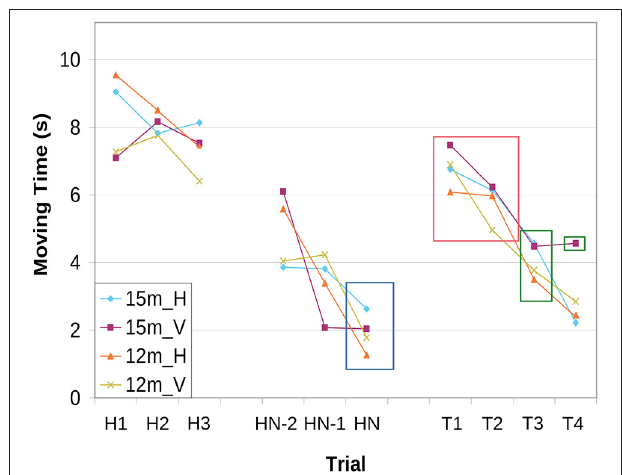
FIGURE 2 | Experimental results: Average movement times for the first (H1-H3) and last three habituation trials (HN-2, HN-1, HN), as well as the test trials (T1-T4). Movement times are averaged across age group (12 or 15 months) and habituation condition, horizontal (H) or vertical (V). Average movement time satisfies the habituation condition in all groups in the last habituation trial, HN, marked by the blue box. The orange box marks significant dishabituation (difference to last habituation trial, HN) to the new movement direction in T1 and T2. Spencer-Thompson dishabituation is significant (difference to HN) in some trials and for some age groups/conditions, marked by the green